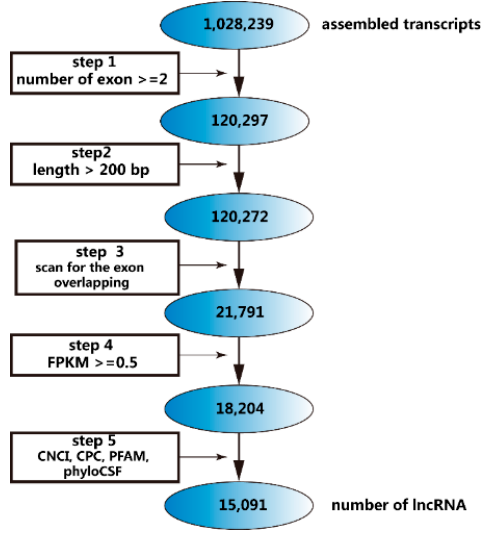
Figure 1. The five-step filter we used to screen long noncoding RNAs (lncRNAs) and the number of residual transcripts after each step was shown.